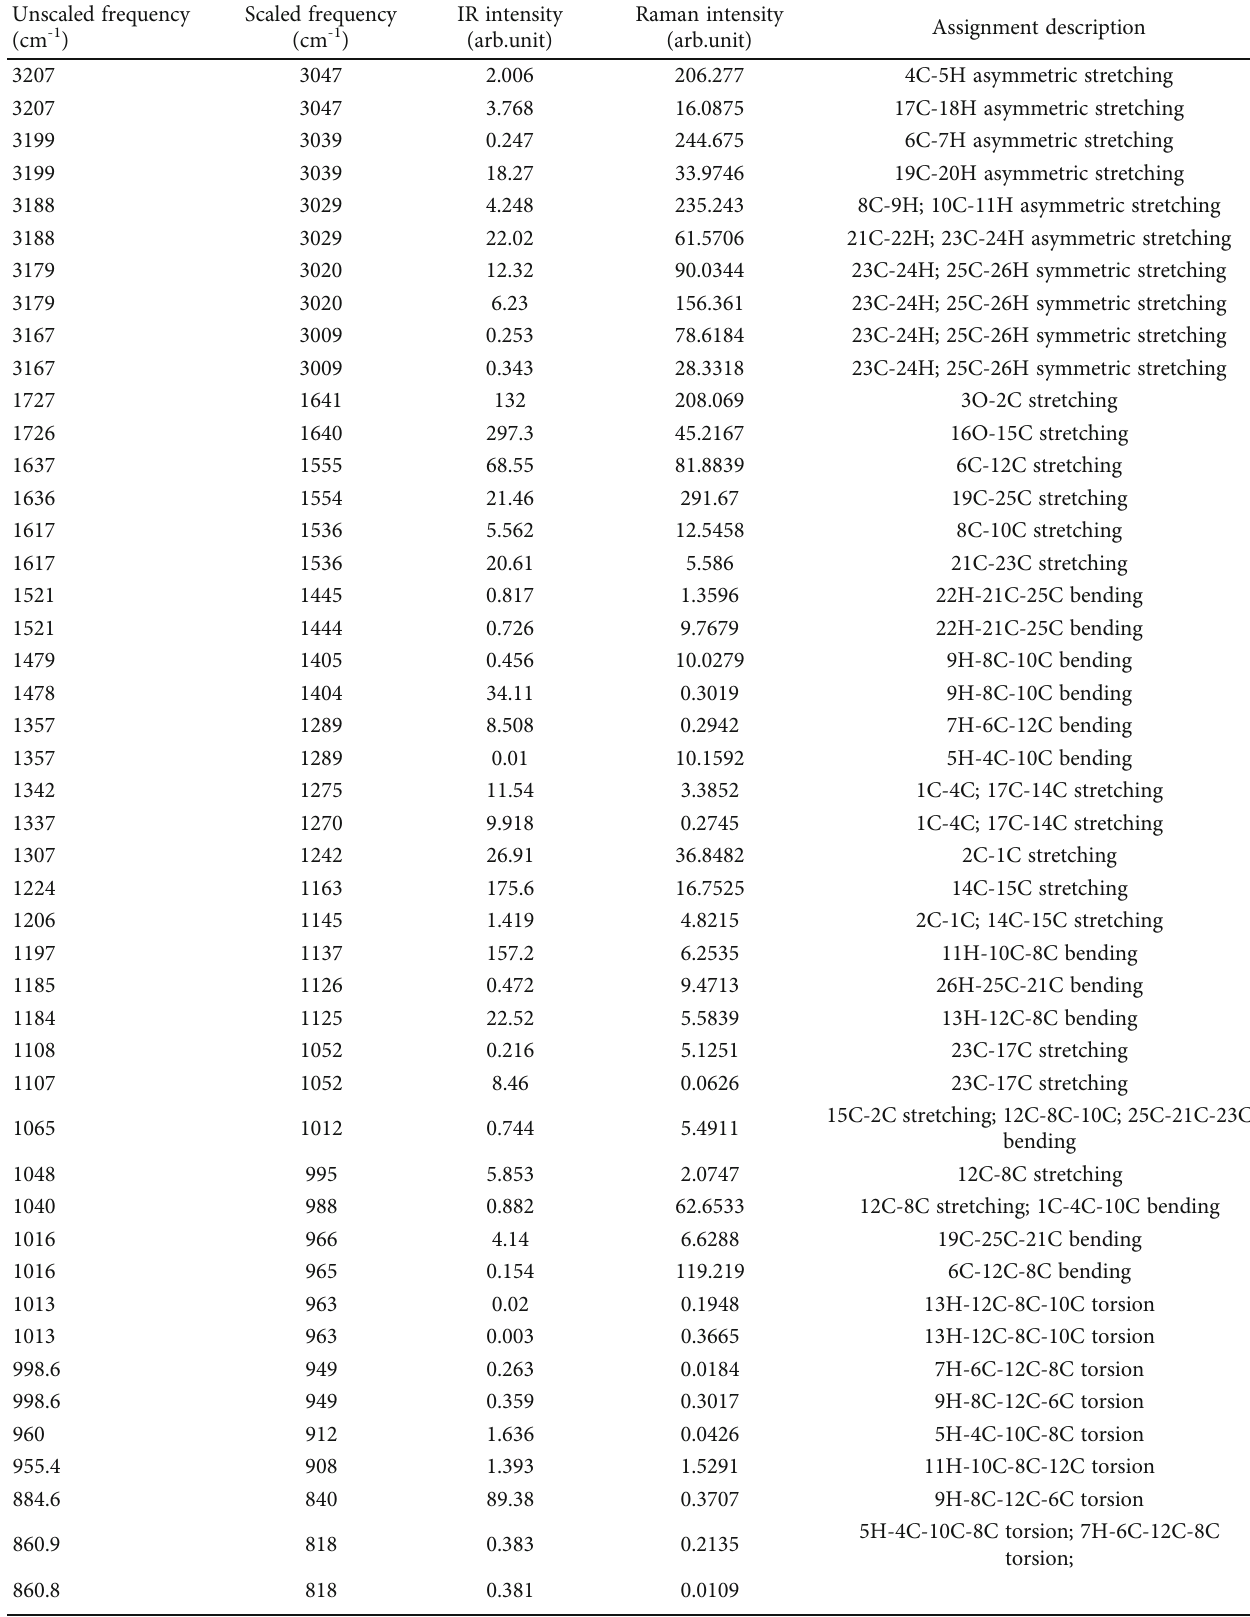
Table 2: Wavenumbers (cm -1 ) and relative intensities of calculated Fourier infrared and Raman spectra of benzils. Unscaled